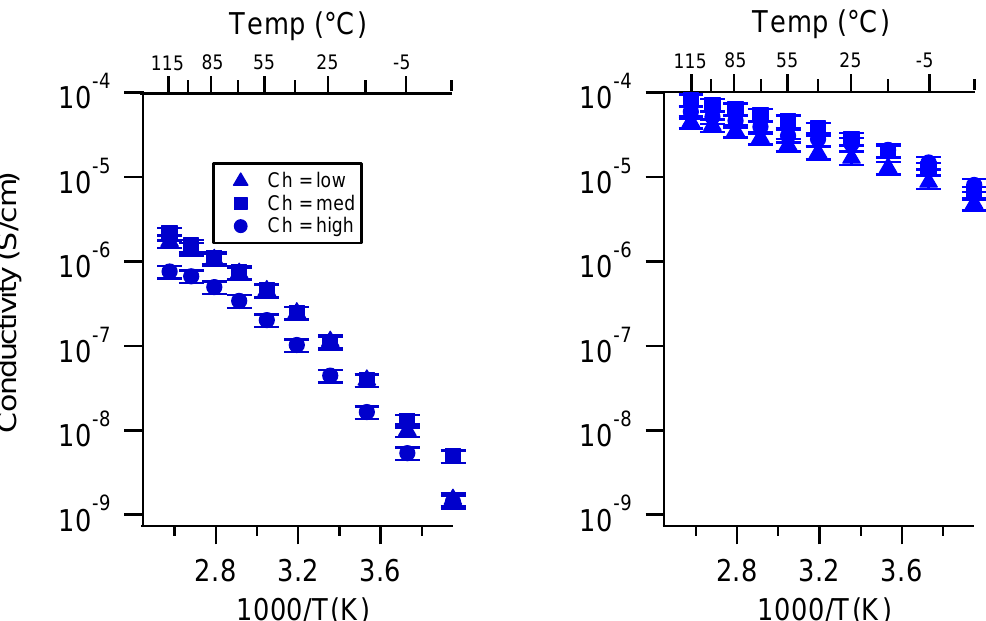
Figure A14. Conductivity as a function of charge density for PEGDMA1000_SSNa (left) and PTHFDA1000_STFSINa (right) SIPEs swelled with DEG. Temperatures ranged from − 20 °C to 115 °C.